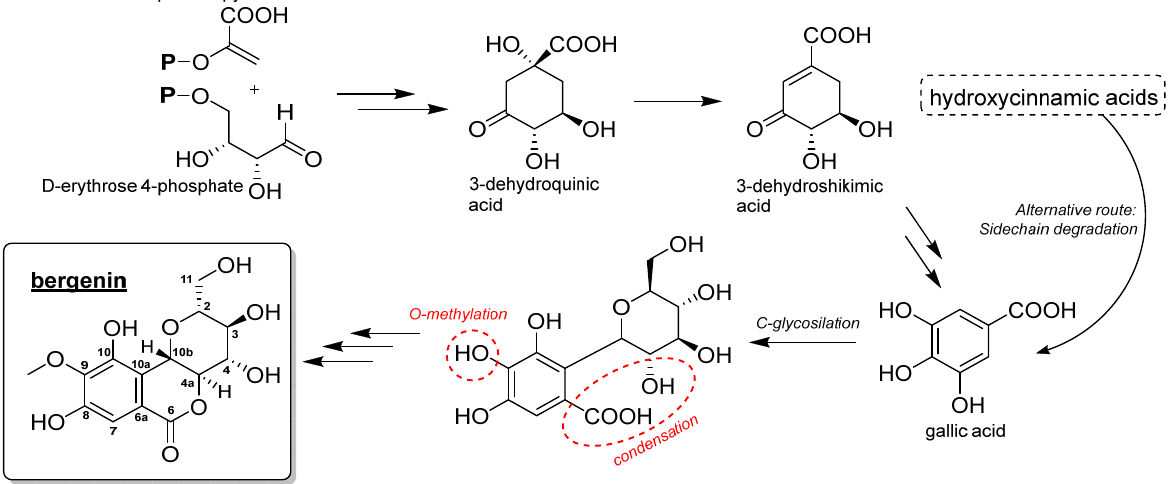
Figure 1. The biosynthesis of bergenin in plants is related to the gallic acid biosynthetic